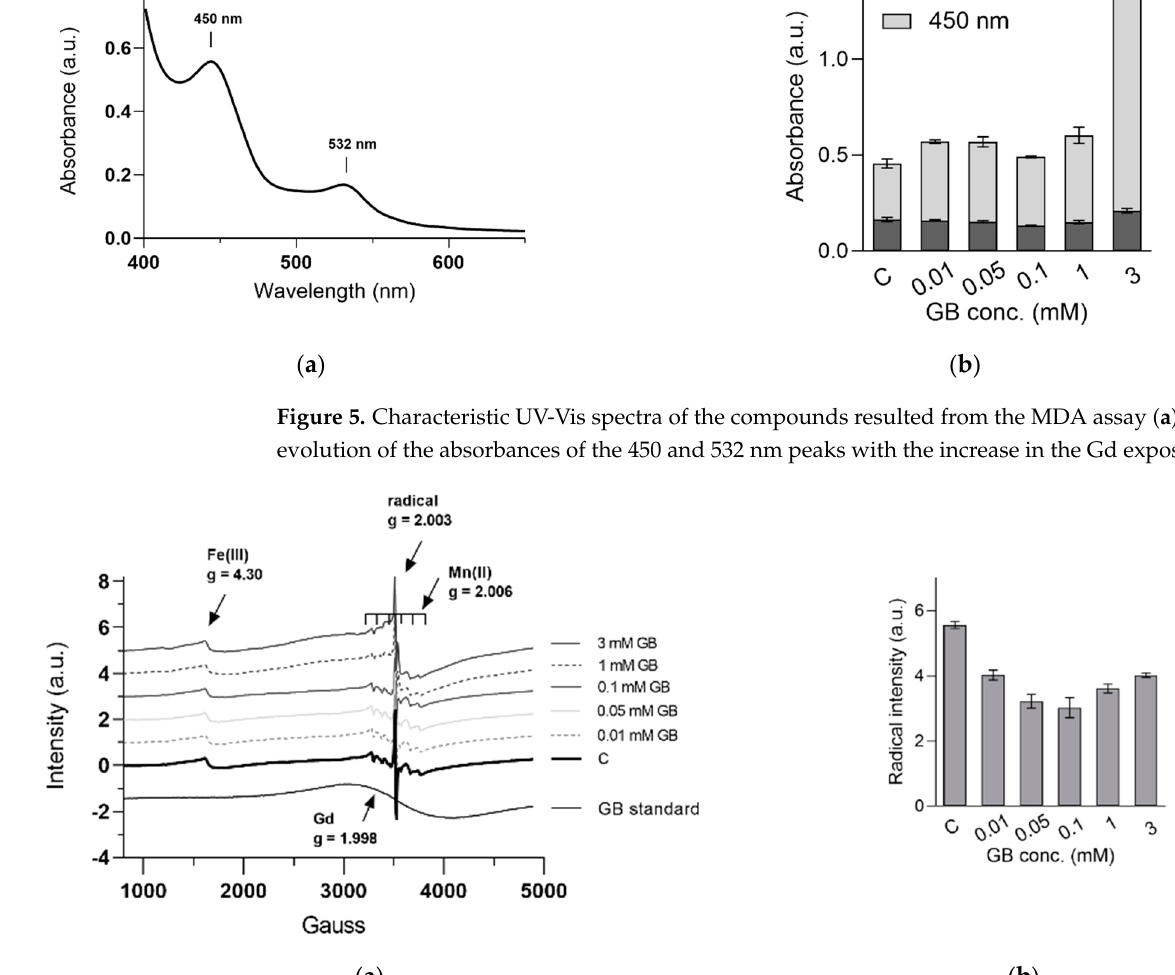
Figure 5. Characteristic UV-Vis spectra of the compounds resulted from the MDA assay ( a ) and the evolution of the absorbances of the 450 and 532 nm peaks with the increase in the Gd exposure ( b ).